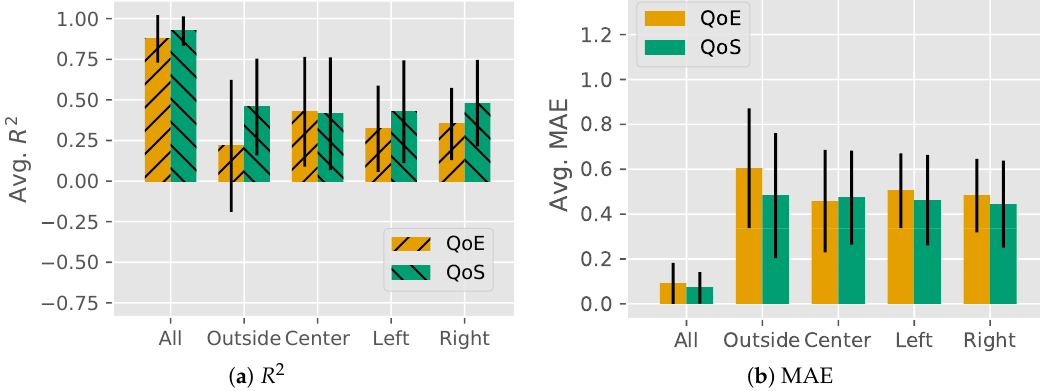
Figure 6. R 2 and MAE results for the EEG-based prediction of the same images in the augmented binocular vision (SAR) setting; see